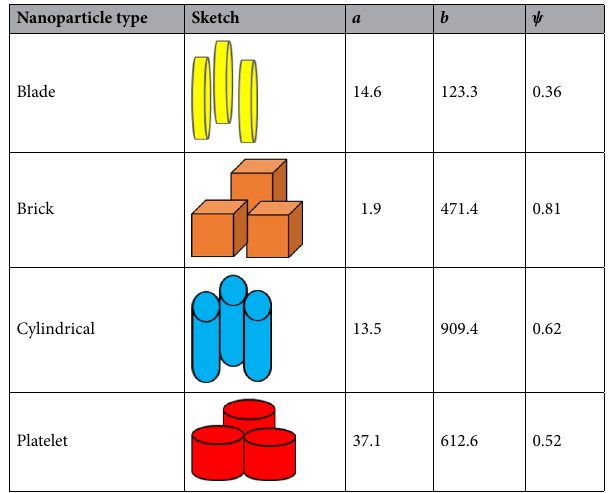
Table 1. Different shapes of nanoparticles with corresponding values of a , b and ψ